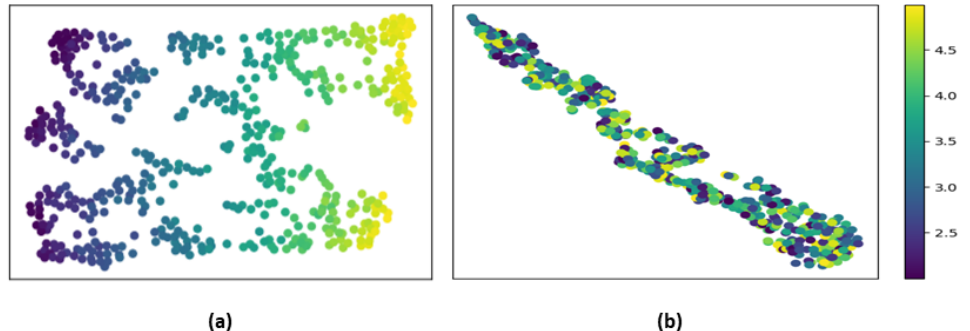
Figure 4. tSNE plots of learned features for different methods: ( a ) For Baseline CNN model [7] ( b ) For DcCNN model.